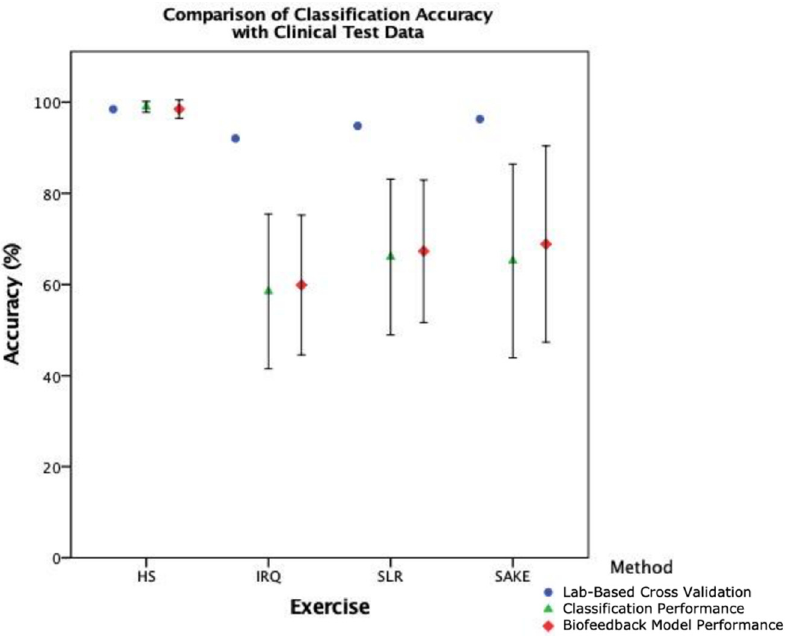
Figure 8. The difference in classification accuracy between the lab-based cross-validation, manually segmented classification performance, and automatically segmented biofeedback model performance when testing with clinical data.